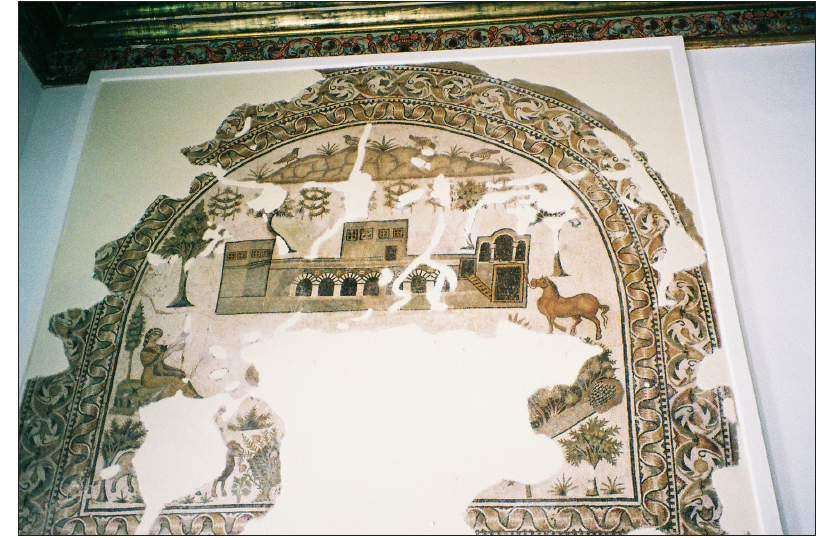
Figure 7: Tabarka, side apse of suburban villa, building with landscape and woman spinning. (Photo: Verity Cridland, licensed under Creative Commons Attribution- 2.0 Generic